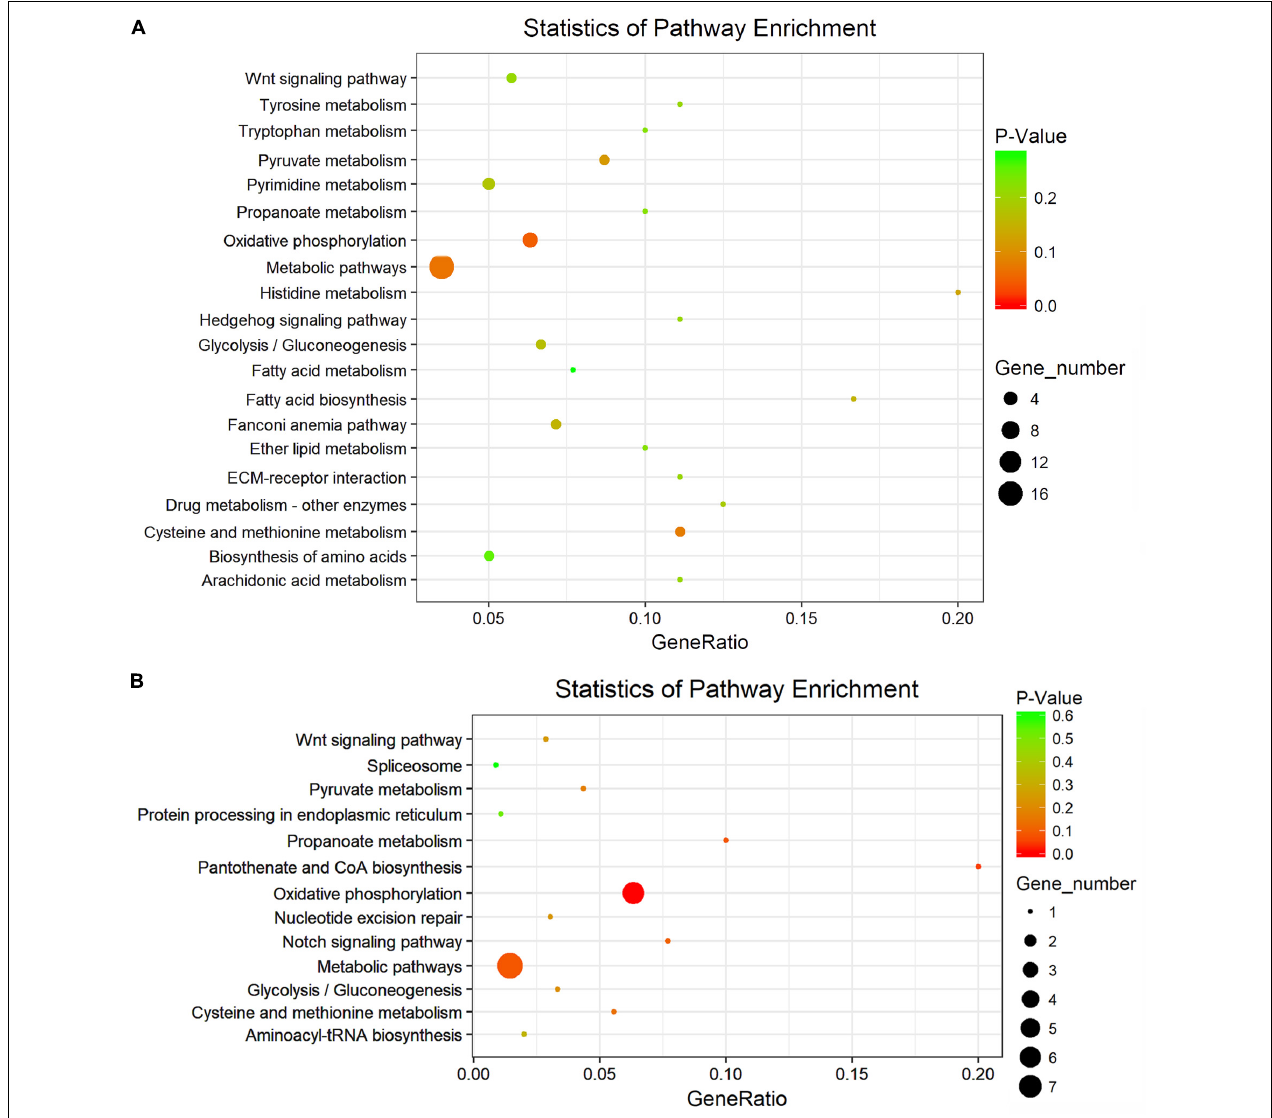
FIGURE 6 | KEGG analysis with the 20 most enriched pathways. The coloring of the P value indicates the significance of the enriched factor. The circle indicates the target genes that are involved, and the size is proportional to the gene number. (A,B) KEGG analyses with the top 20 enriched pathways of the differentially expressed mRNAs in S. japonicum between S_F vs. B_F (A) and between S_M vs. B_M (B)